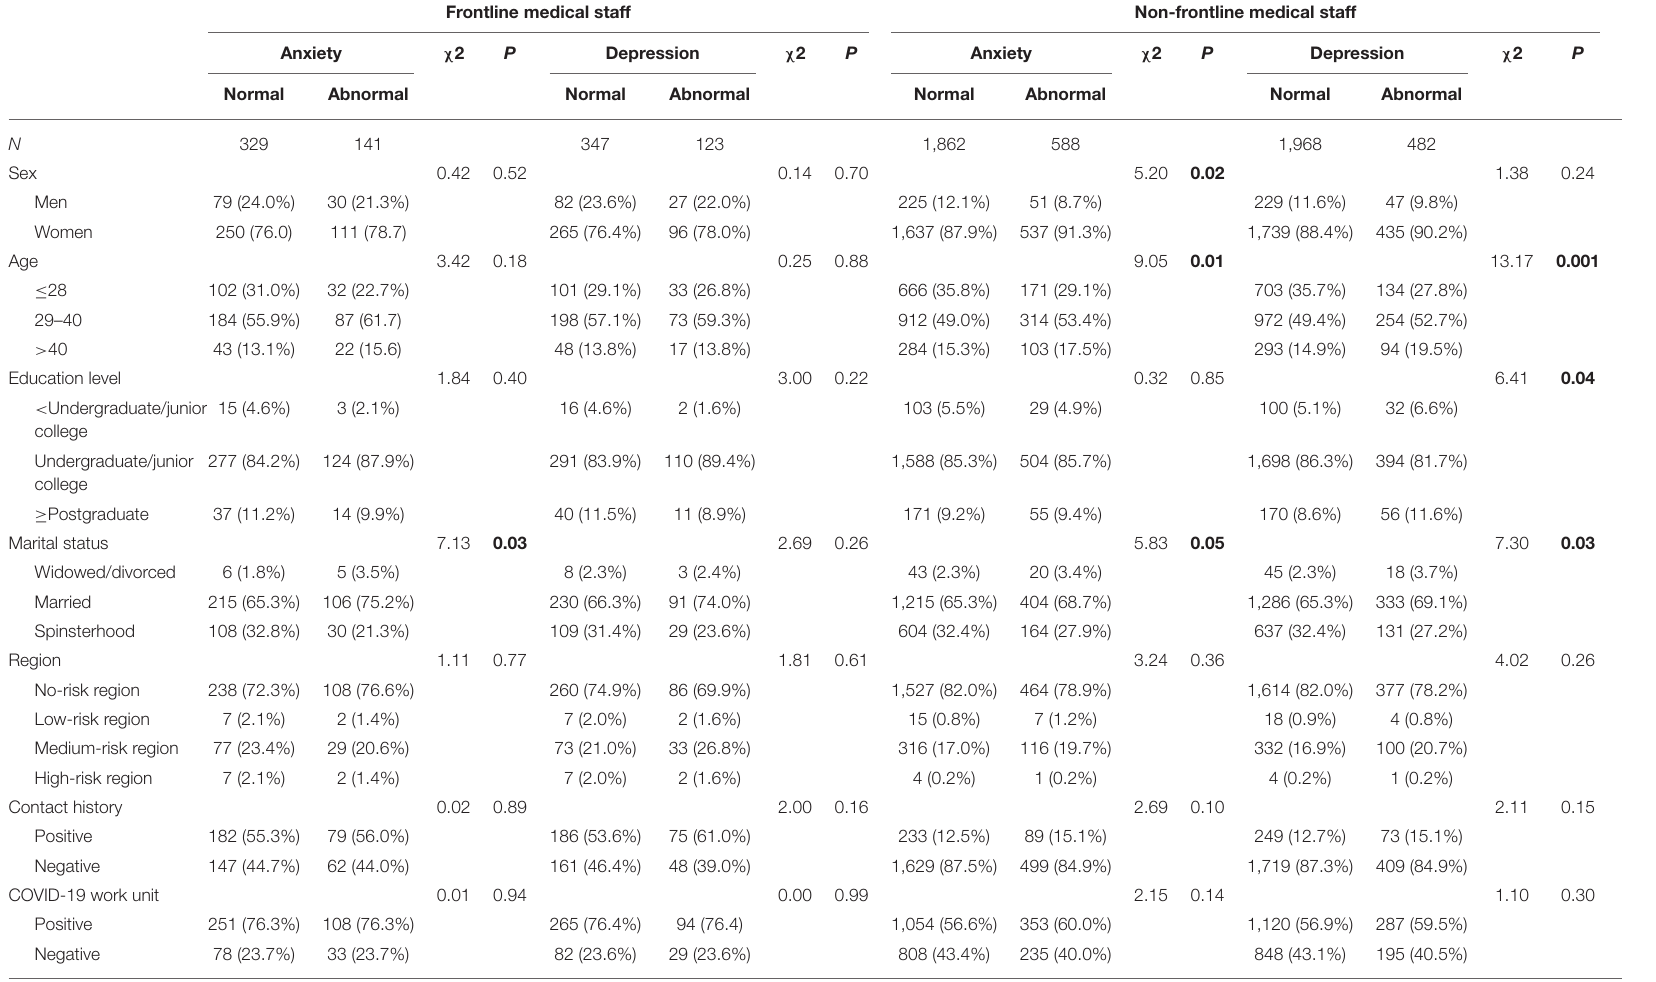
The bold values indicate that the differences are statistically